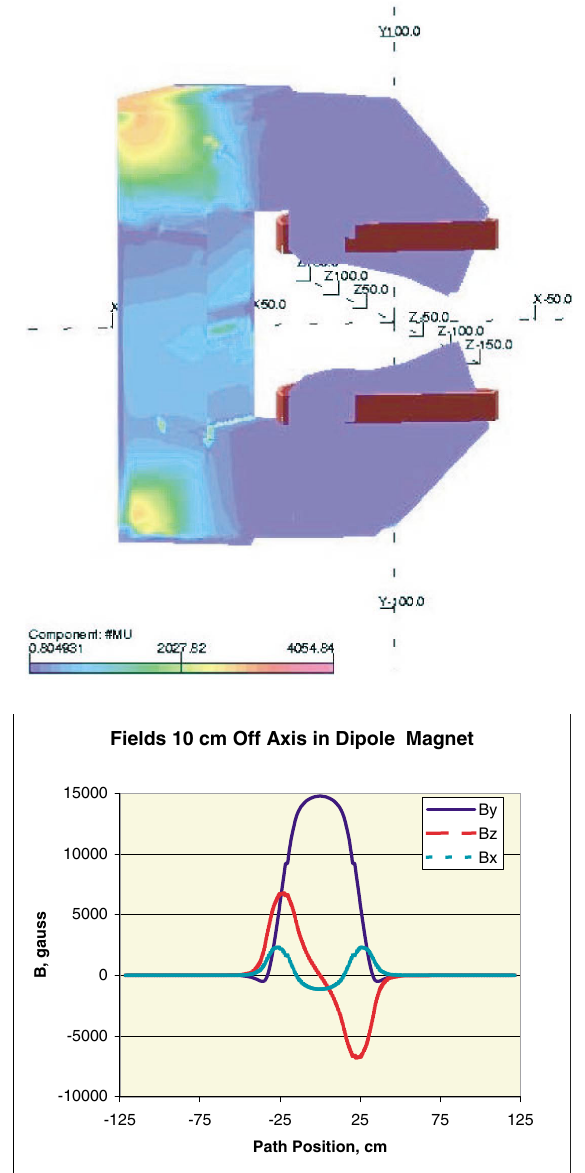
FIG. 35. (Color) The figure shows a computer model of a 52 cm radius dipole with index n (cid:4) (cid:1) 1 components radially 10 cm off axis.